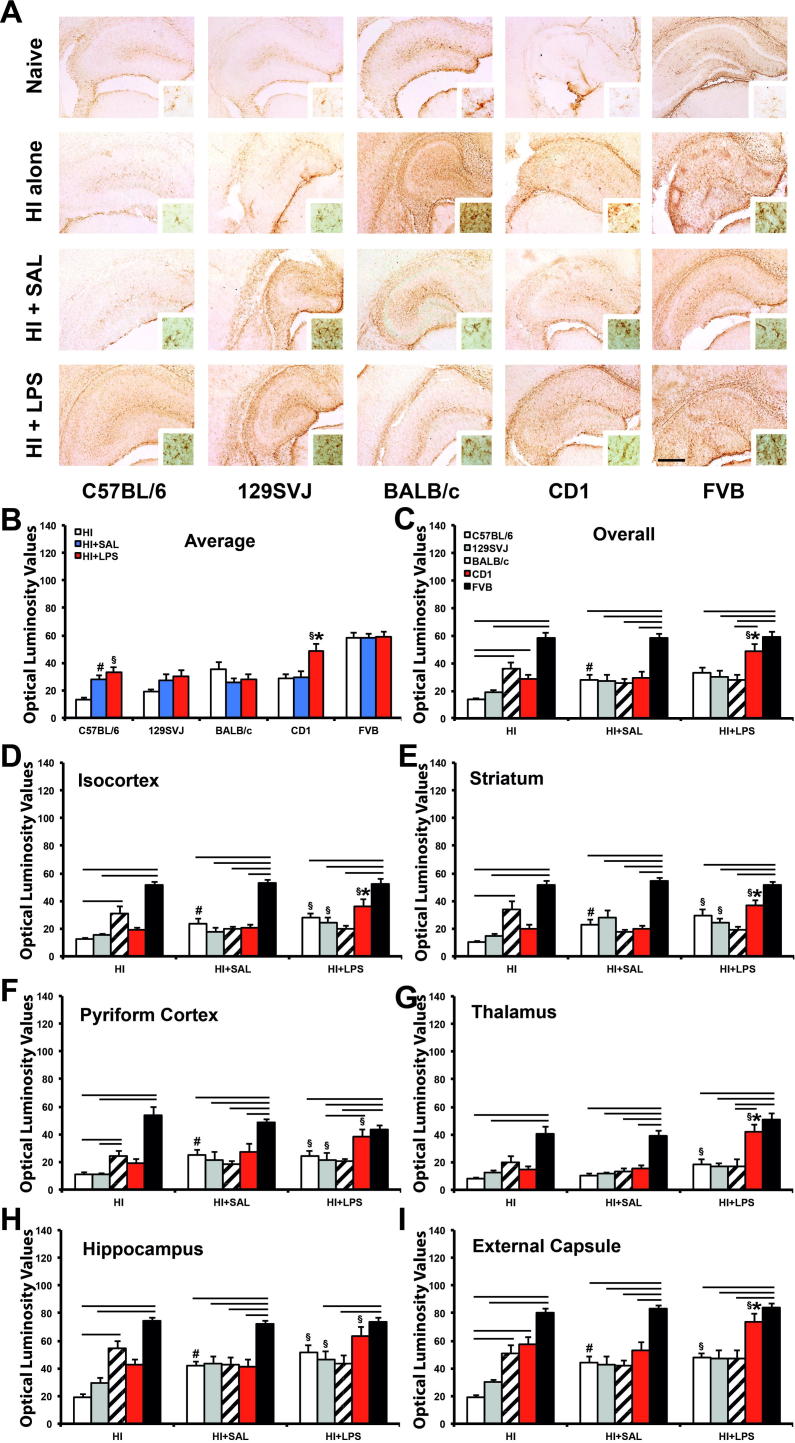
Strain-specific appearance of contralateral astrogliosis in the non-occluded forebrain hemisphere following hypoxia–ischemia. (A) Hippocampal sections showing distribution of GFAP-IR in C57BL/6, 129SVJ, BALB/c, CD1 and FVB naïve animals (top row), only exposed to HI insult (second row), previously injected with saline (third row) or pre-exposed to LPS 12 prior to hypoxia–ischemia (last row). Distribution of GFAP-IR in C57BL/6 animals shows an increase in contralateral astroglial activation in the HI + SAL group when compared to HI alone. This increase was sometimes more pronounced in LPS-treated mice (B, C). (D–I) OPTIMAS Quantification of GFAP-IR showed significant treatment-induced increase in C5BL/6 and CD1 strains, in the former for HI + SAL vs. HI alone and in latter for HI + LPS vs. HI + SAL and HI alone, both overall (B, C) as well as in 5/6 and 4/6 brain regions, respectively (D–I). Interestingly, interstrain comparison revealed substantially higher GFAP-IR in FVB animals when compared to C57BL/6 and 129SVJ mice across all three treatments – HI alone, HI + SAL, HI + LPS – however, FVB animals did not show a difference in contralateral GFAP-IR between the three treatments. p < 0.05 for Kruskal–Wallis one-way analysis, followed by Dunn multiple comparison test (∗for HI + LPS vs. HI + SAL, §for HI + LPS vs. HI alone, #for HI + SAL vs. HI alone, overhead bar for interstrain treatment comparison). Bar scale = 0.5 mm.